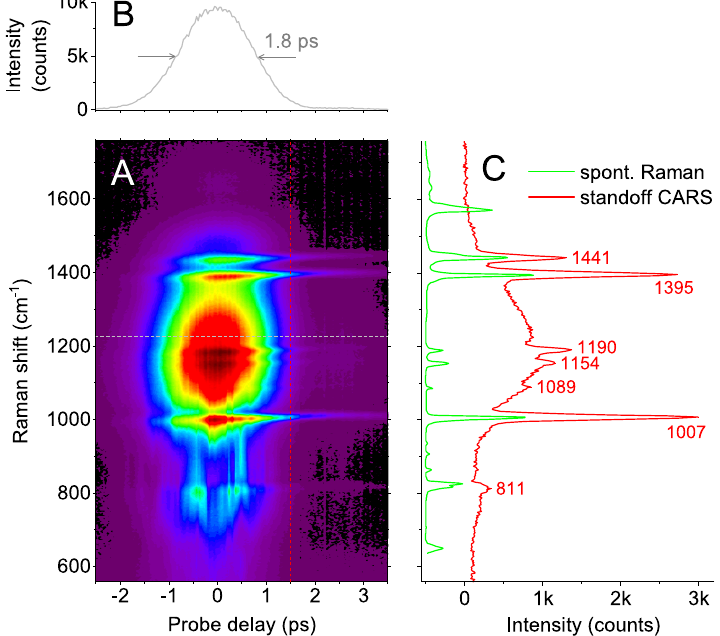
Figure 3. ( A ) Standoff CARS spectrogram of NaDPA powder. Pump, Stokes, and probe pulse energies are 4, 4, and 3 μJ, respectively. The spore sample is placed at 1 m from the laser system and the integration time is 100 ms. ( B ) Horizontal cross-section (gray line) at Raman shift of 1220 cm − pulse duration. ( C ) Vertical cross-section (red line) at probe delay of 1.5 ps provides a broadband standoff CARS spectrum of NaDPA; Raman spectrum (green line) of NaDPA powder acquired with a micro-Raman spectrometer 36